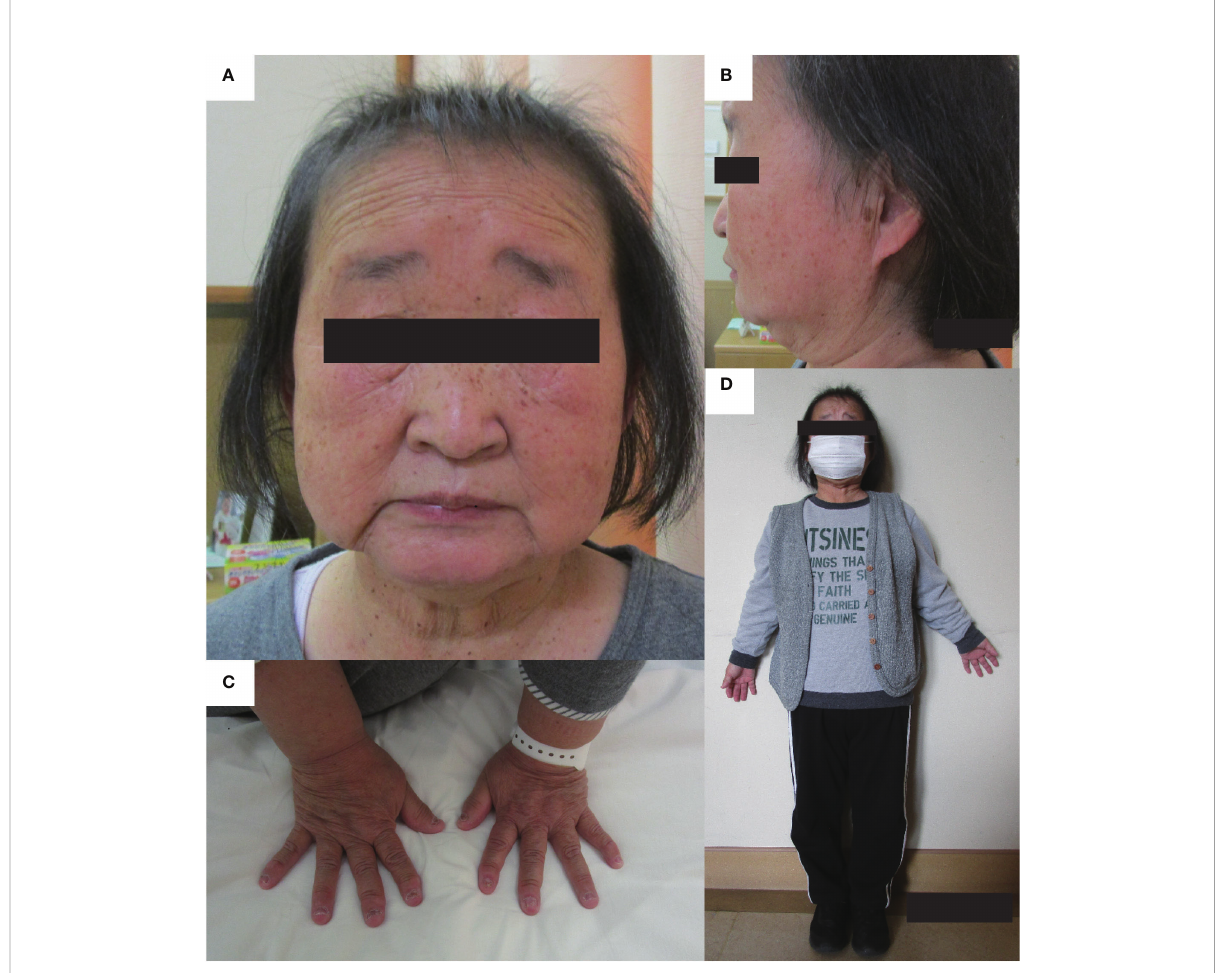
FIGURE 1 Physical features. The physical features of the patient are shown in panels (A – D) . (A, B) There are no facial abnormalities, such as cleft palate, low-set auricles, or small mouth; however, the nasal root is fl at. (C) brachydactyly was shown. (D) The patient ’ s height and arm span were 126.2 cm, and 111.0 cm. Mild disproportionate shortening and short limbs were